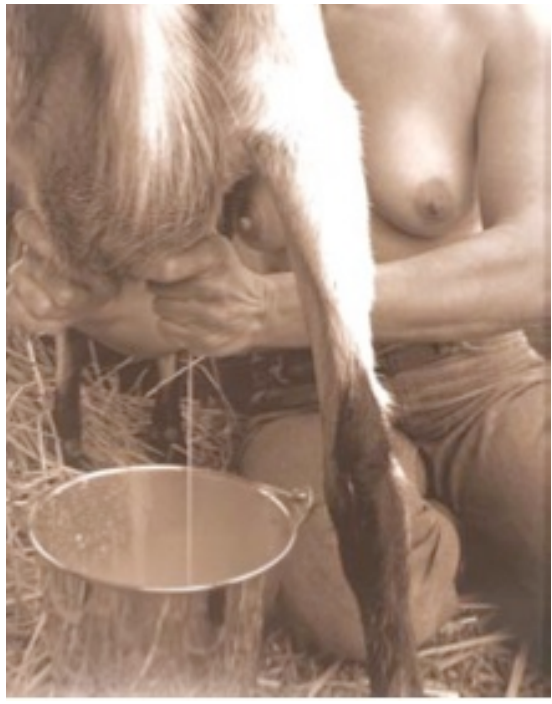
Fig. 6. January, Breast of Canada, nude fund-raising calendar, 2007. (Photo credit: Christian McLeod Reprinted with Permission from